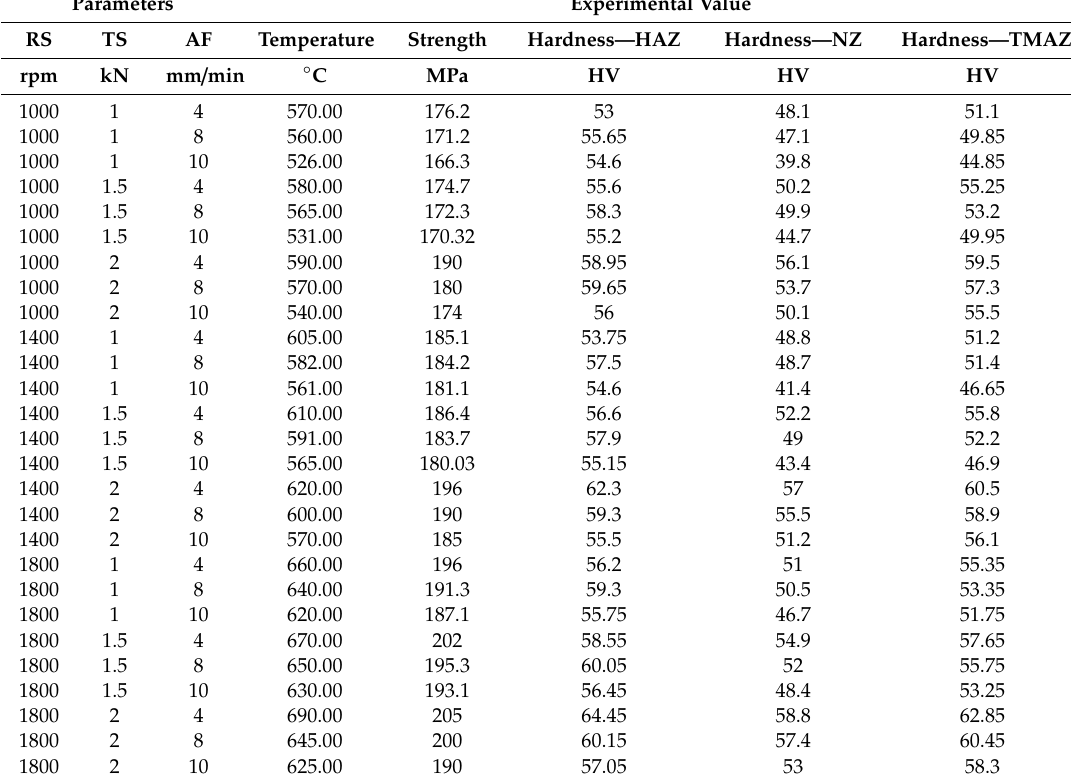
Table 6. Responses after experimentation for full factorial analysis.